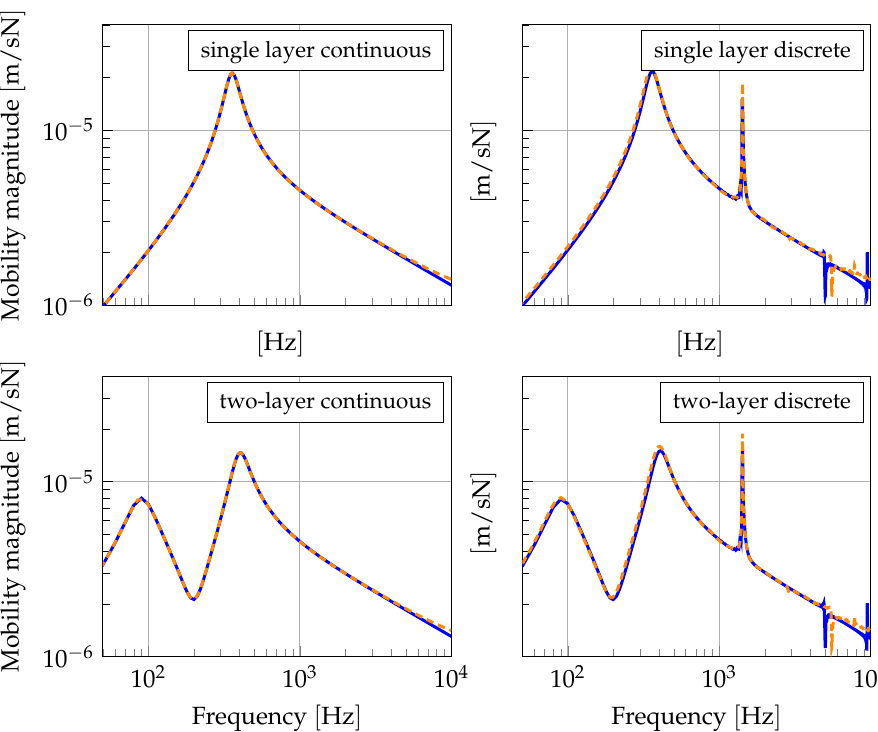
Figure 12. Point mobilities of an undamped infinite beam ( t end = 1 s) for different types of elastic foundations. Discretely supported beams are excited mid-span.